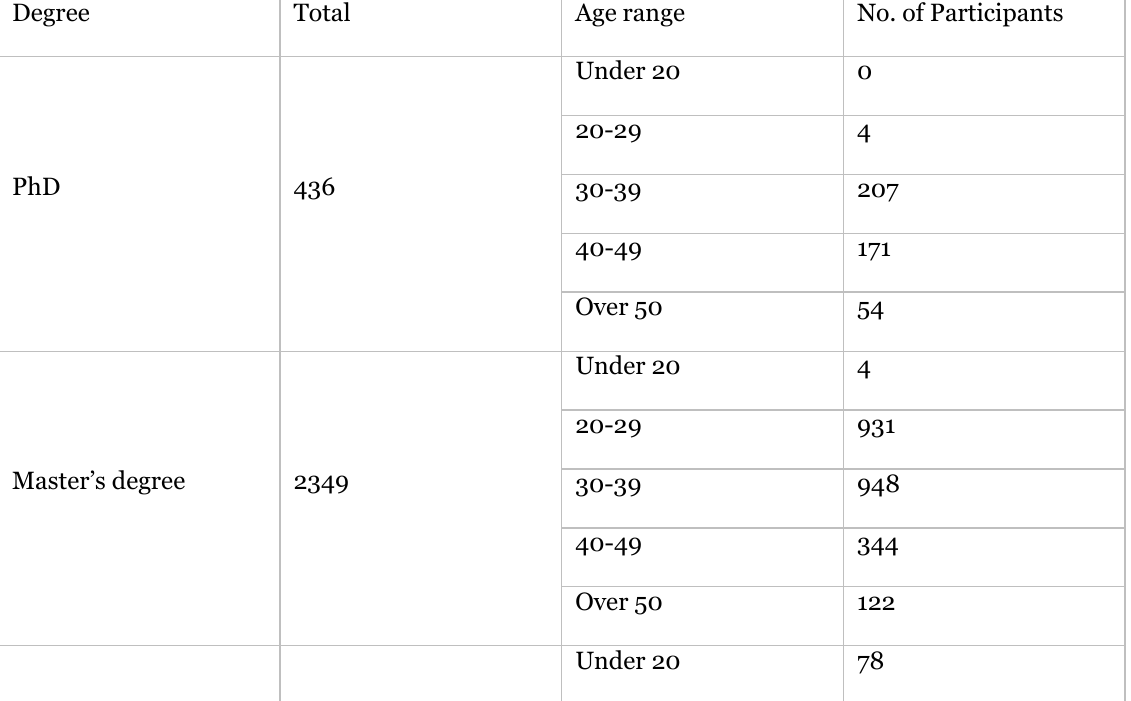
Participants' Ages and Levels of Educational